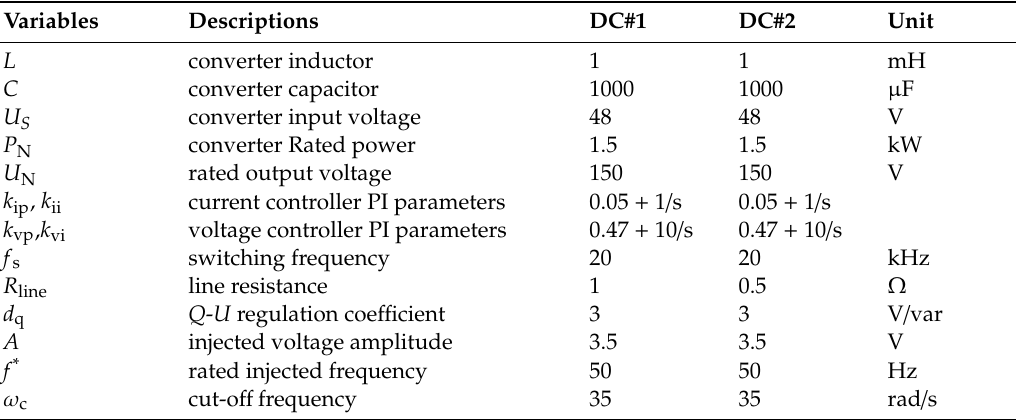
Figure 12. The experiment setup. ( a ) photograph; ( b ) configuration. Table 3. The experiment setup